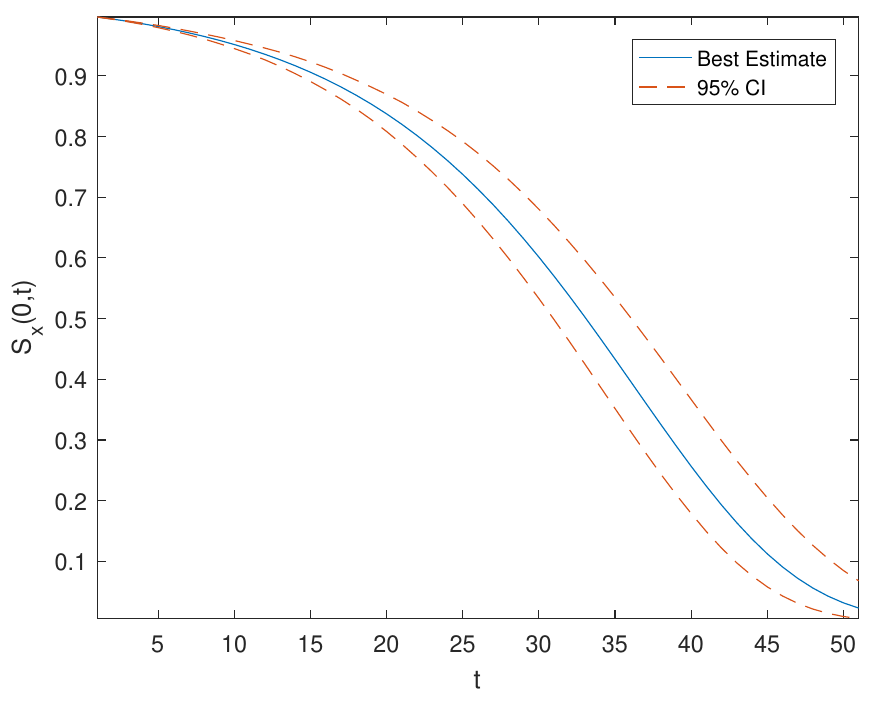
Figure A2. Simulated Survival Function From